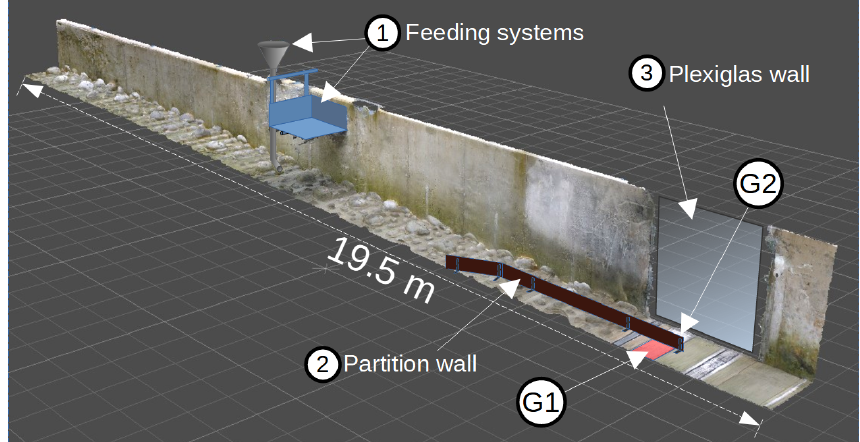
Figure 3. Oblique view of the Obernach flume test reach with a total length of 24m and width of 1m. The bed surface is paved with particles with diameters equaling the characteristic D 67 and D 84 sizes of the natural beds of the reconstructed sites. Grains were fed into the channel 8m upstream from the SPG system location (G1 and G2) using either a vertical feed pipe or a tiltable basket (1). The sensor plate G1 (in red) was shielded from direct particle impacts by the 4m long partition wall (2). The partition wall and the impact plates were decoupled from each other by a 2mm vertical gap to prevent disturbances of the recorded signal. Plexiglas walls (3) on each side of the flume facilitated video recordings of the experiments.